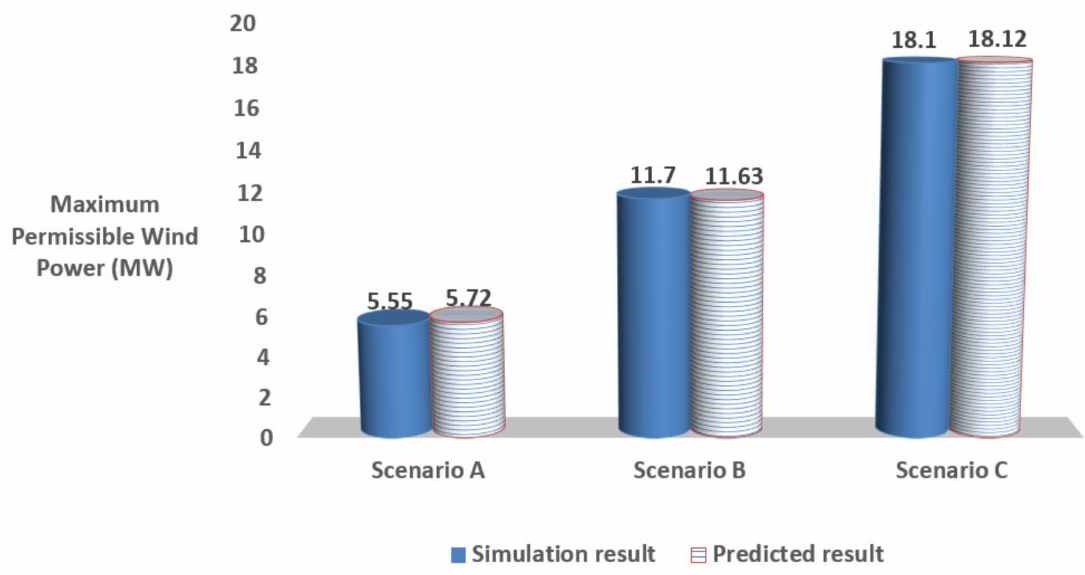
Figure 11. Maximum permissible wind power generation ensuring 0.95 < V PCC < 1.05 for Scenarios A to